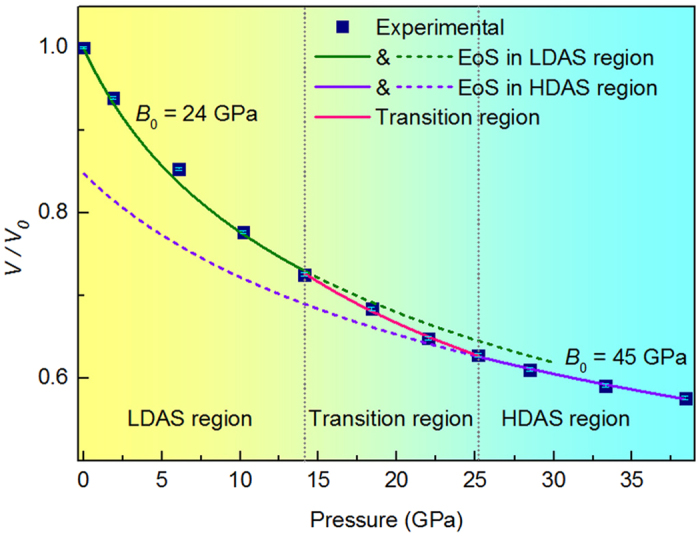
Relative volume V/V0 of Yb62.5Zn15Mg17.5Cu5 metallic glass as a function of pressure, where V0 is initial volume.The green and purple line show the EoS fitting results at LDAS region and HDAS region, respectively. The pink line is for transition region.